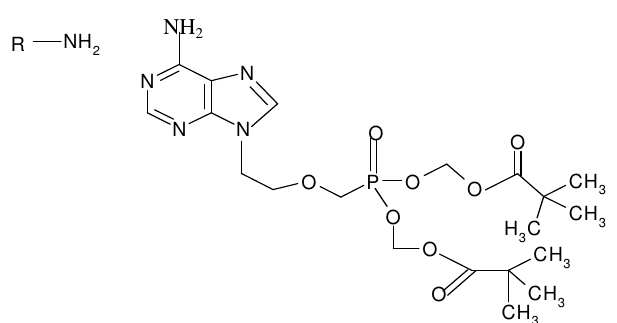
Figure 1 . Structure of adefovir